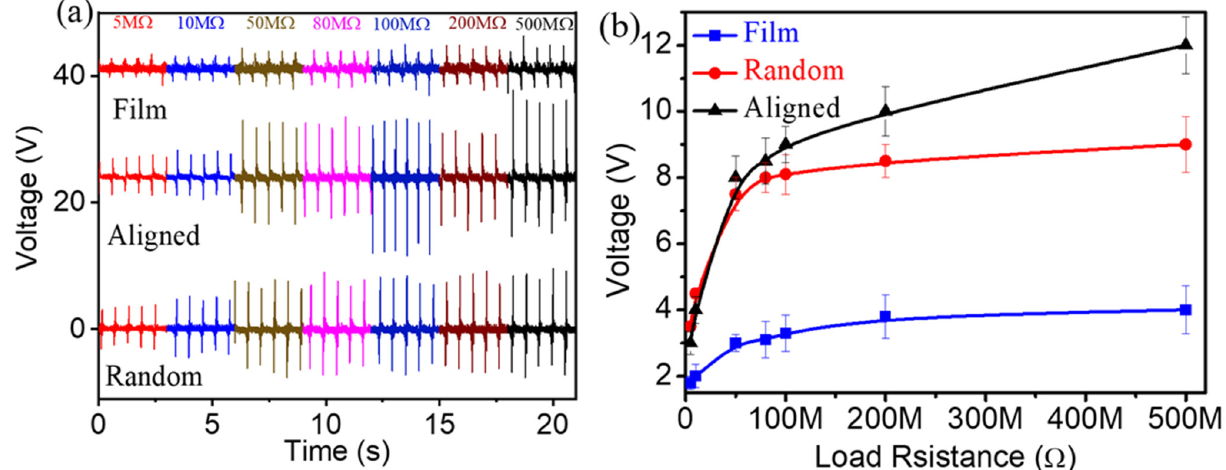
Figure 6. ( a ) Output voltages under various load resistances from nanogenerators assembled by a-PVDF, r-PVDF, and f-PVDF membranes, respectively. ( b ) Variation of output voltages under various external resistances.